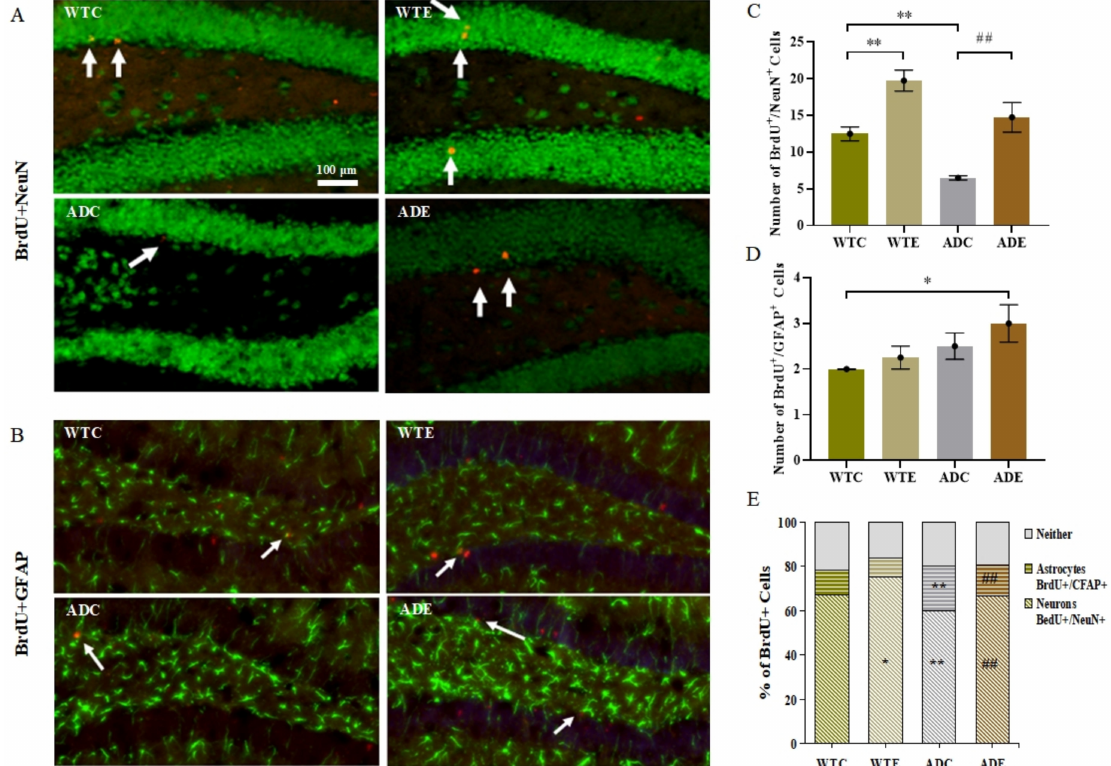
Figure 5. Effect of treadmill exercise on the differentiation of new cells in mice. ( A ) Fluorescence staining images of BrdU/NeuN-positive cells in 6-month-old mice. ( B ) Fluorescence staining images of BrdU/GFAP-positive cells in 6-month- old mice. ( C ) Number of BrdU/NeuN-positive cells in 6-month-old mice. ( D ) Number of BrdU/GFAP-positive cells in 6-month-old mice. ( E ) Differentiation rate of BrdU/NeuN- and BrdU/GFAP-positive cells. n = 4 for each group. * p < 0.05, ** p < 0.01 compared with WTC. ## p < 0.01 compared with ADC. The arrows point to the BrdU/NeuN co-localization- positive cell in ( A ) and BrdU/GFAP co-localization-positive cells in ( B